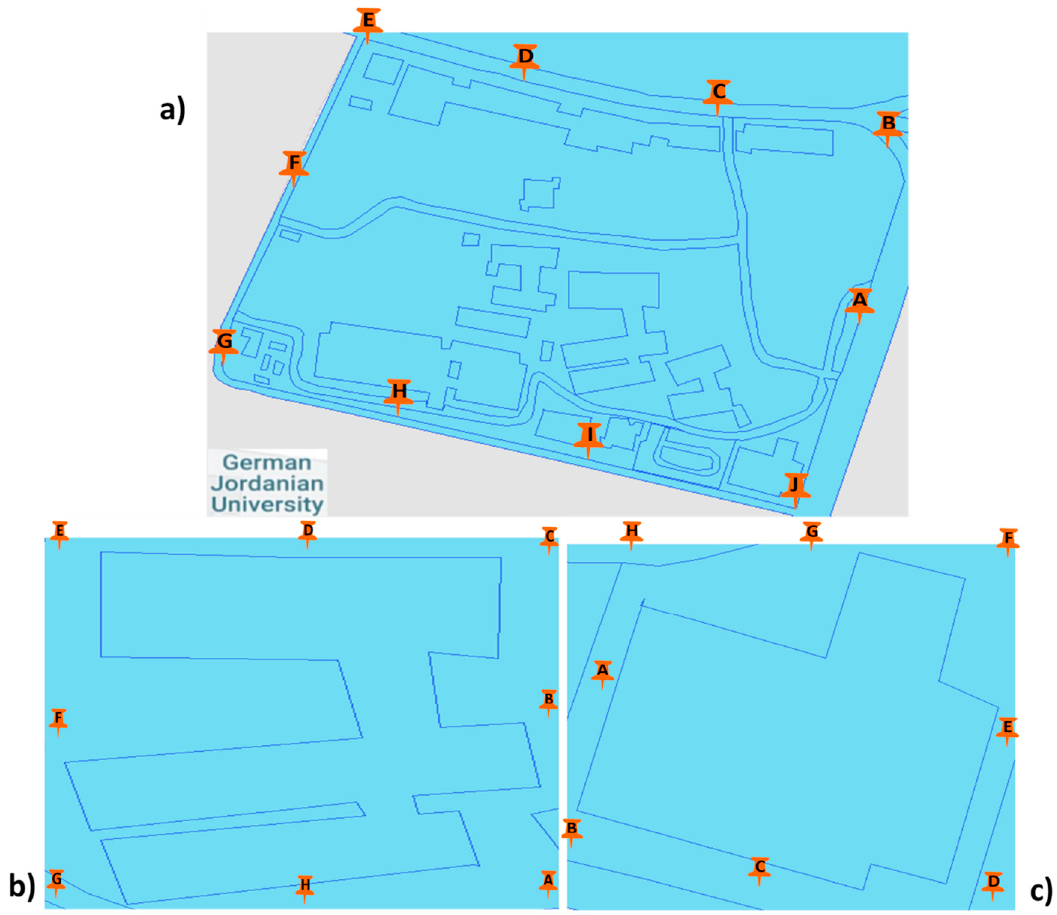
Figure 3. Location of the measured points in the study area: ( a ) 10 points (A-J) around GJU, ( b ) 8 points (A-H) around building C and ( c ) 8 points (A-H) around building H.